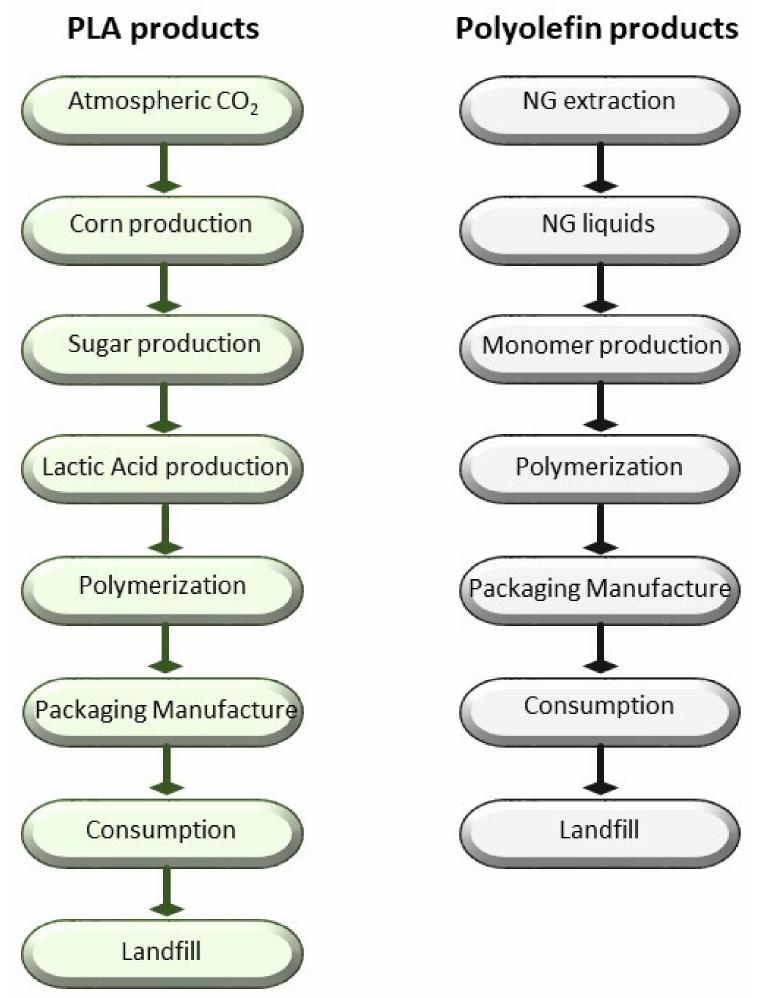
Figure 5. System boundaries for biodegradable poly(lactic acid) (PLA) and synthetic